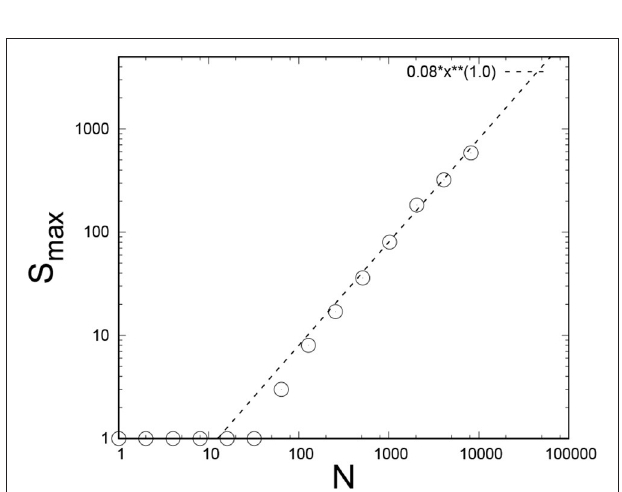
FIGURE 10 | The flow in ( 1 , κ , d ) space projected into the ( κ , d ) plane, under the real space renormalization group. Initial number of fibers N uniform fiber strength distribution on the unit interval. Averages were taken over 10 3 samples.